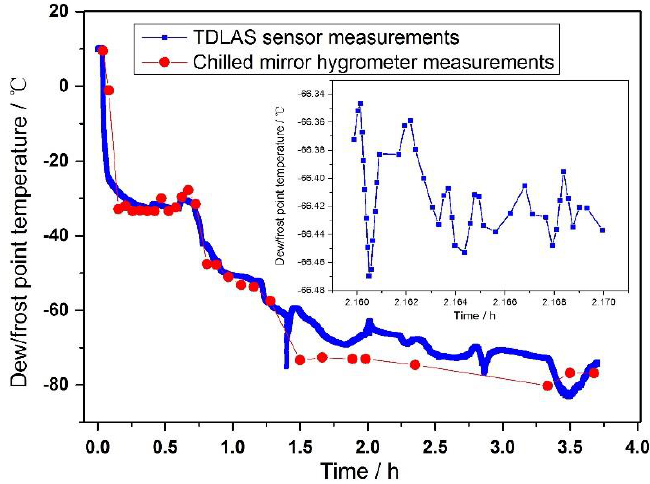
Figure 8. Dew point temperatures determined by both a TDLAS sensor and a chilled mirror hygrometer.